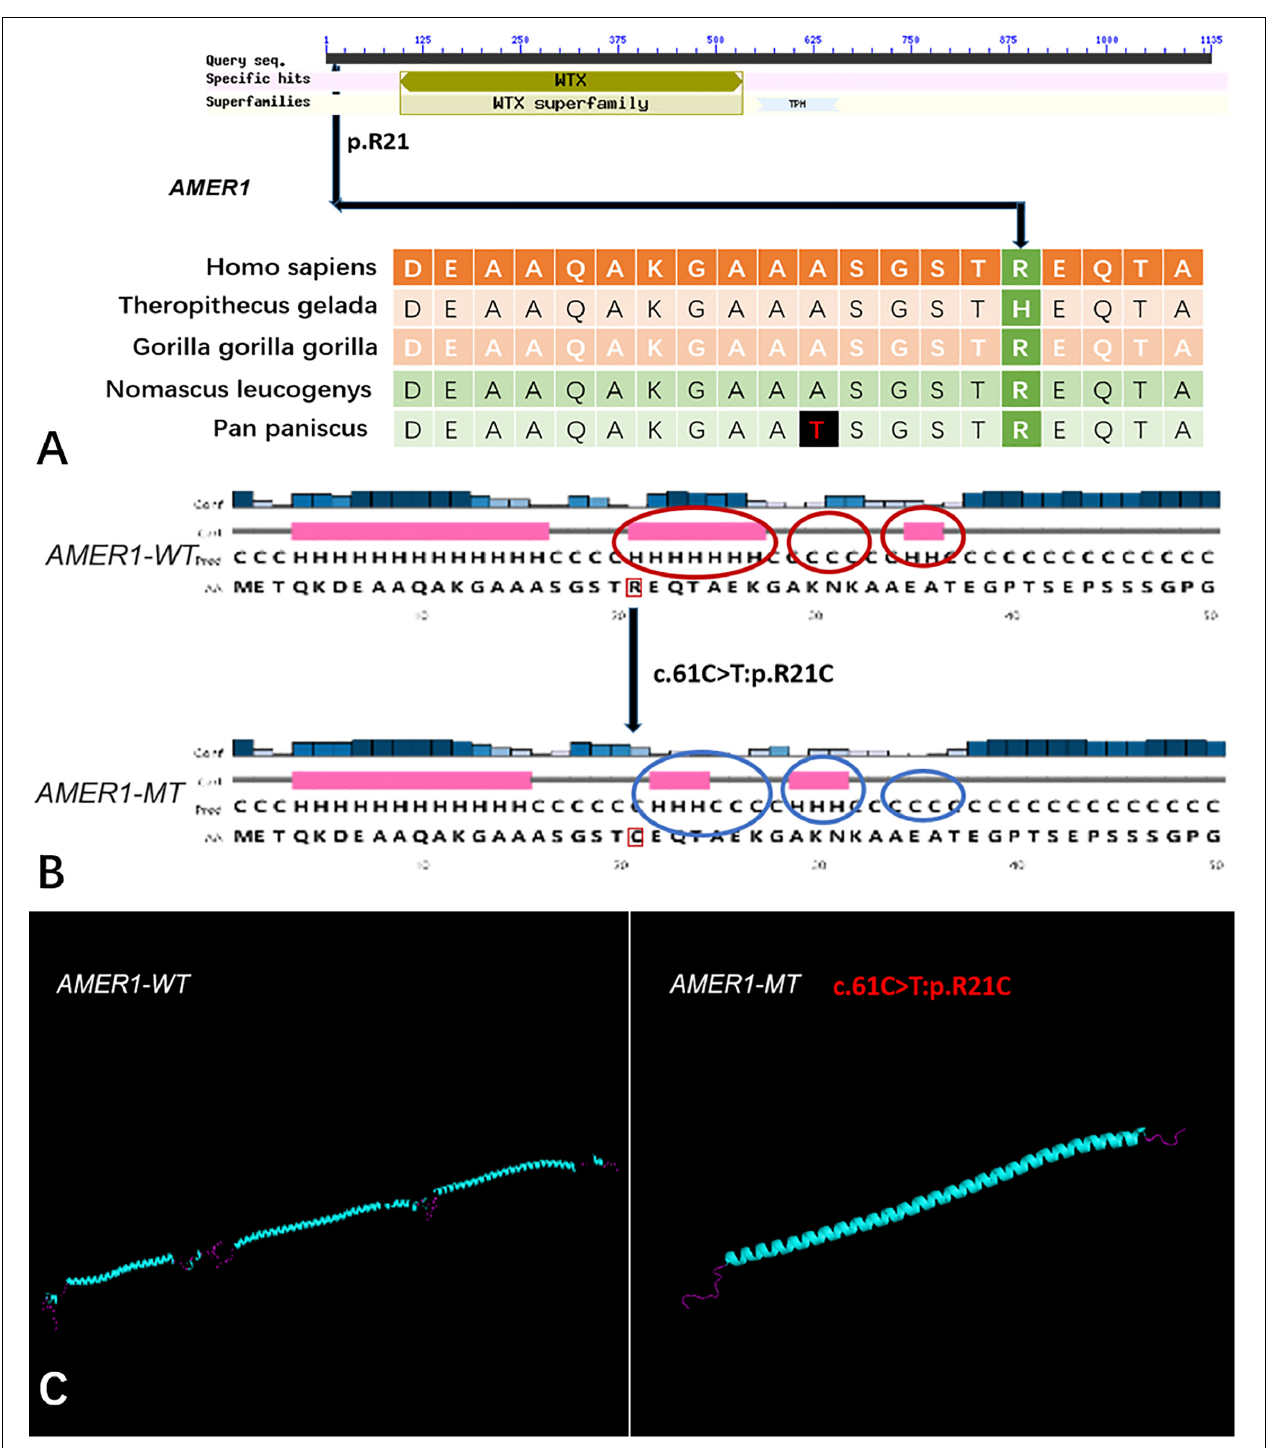
FIGURE 5 | The conservation of AMER1 mutation site in different species, and wild-type and mutated-type secondary and crystal structures. (A) The amino acid affected by the mutation ( AMER1 c.61C > T:p.R21C) was relatively conserved among different species; (B) The mutation ( AMER1 c.61C > T:p.R21C) was predicted to modify the local secondary structure of the protein, which were circled as red and blue; (C) Template-based modeling of the tertiary structures was carried out. Global view of the crystal structures of wild-type and mutated-type proteins demonstrated the change of protein structure brought by the amino acid substitution. Local homology prediction demonstrated high confidence rate (69.52%). WT means wild-type; MT means mutated-type.